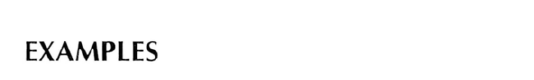
FIGURE 5 Period estimate with spline